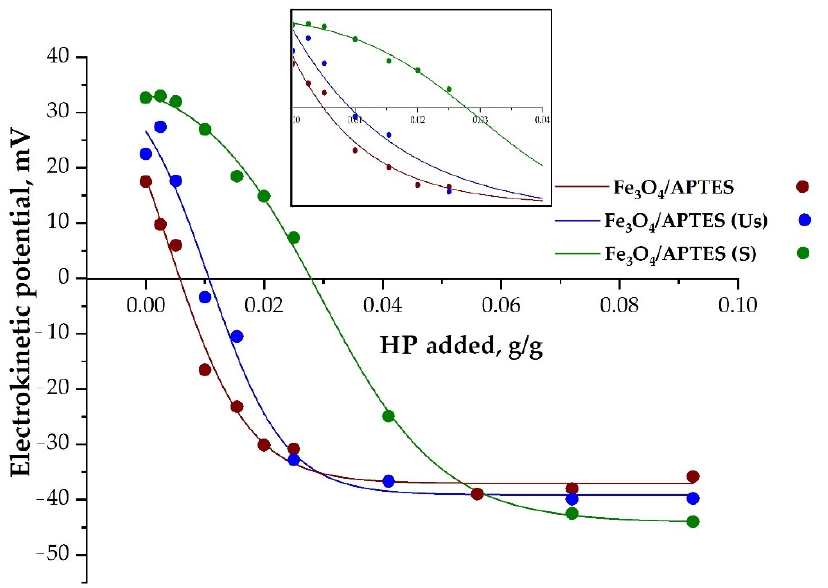
Figure 6. Effect of HP on the surface charging of Fe 3 O 4 /APTES samples (pH ~5 and KCl = 0.01 M). The curves were drawn as guidelines by eye.